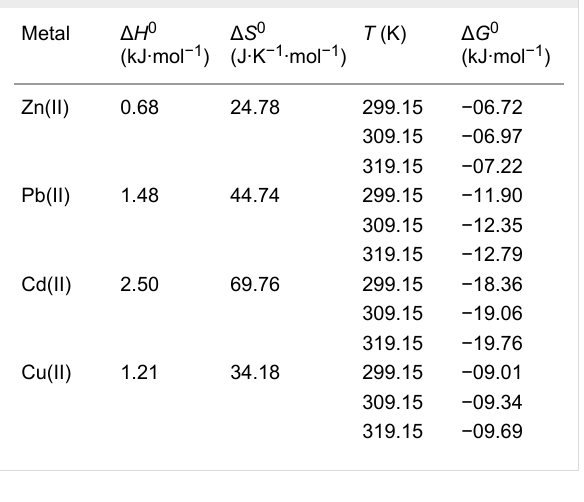
Figure 9: Langmuir and Freundlich adsorption models fits of Zn(II), Pb(II), Cd(II) and Cu(II)) on SiNL. Table 3: Thermodynamical